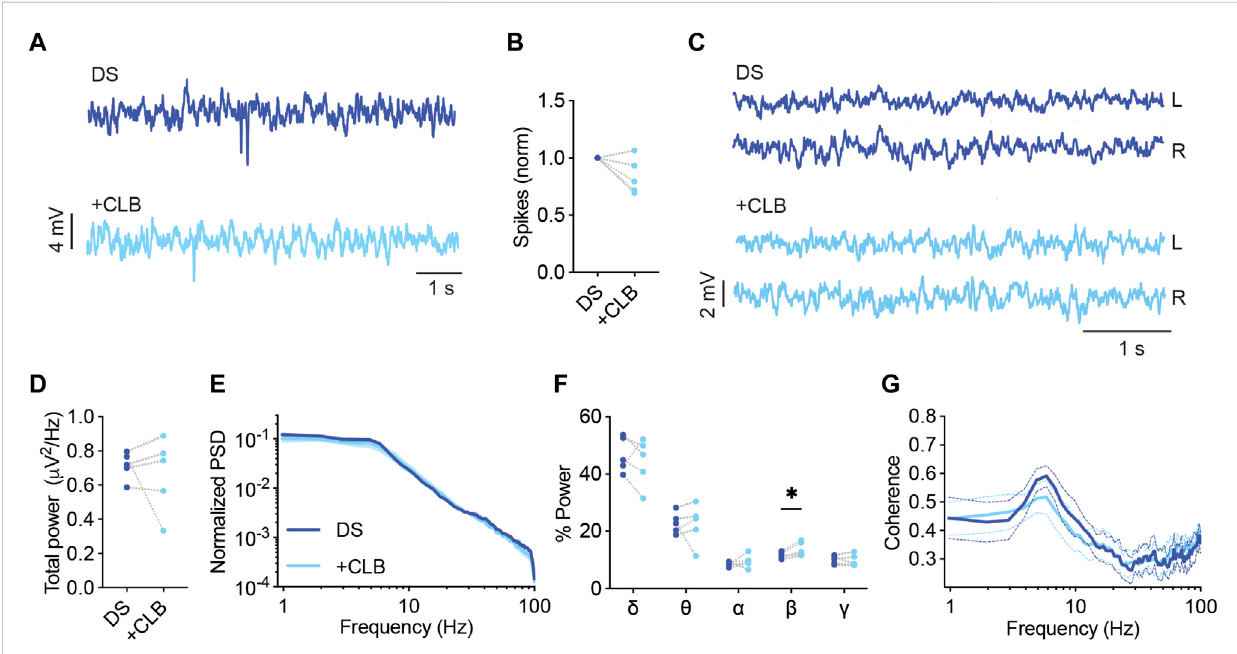
FIGURE 3 CLB treatment modulates the spectral properties of background ECoG in DS mice. (A) Representative traces of epileptic activity before and after acute administration of CLB (10 mg/kg) (B) . The change in the frequency of interictal spikes. (C) Representative examples of background activity. (D) The effectontotalpower. (E) ECoGpowerdensitypro fi lesnormalizedtothetotalpowerpriortodrugadministration. (F) Therelativepowerineachfrequency band. (G) Interhemispheric coherence plotted over the 1 – 100 Hz spectrum. DS, n = 5. * p <